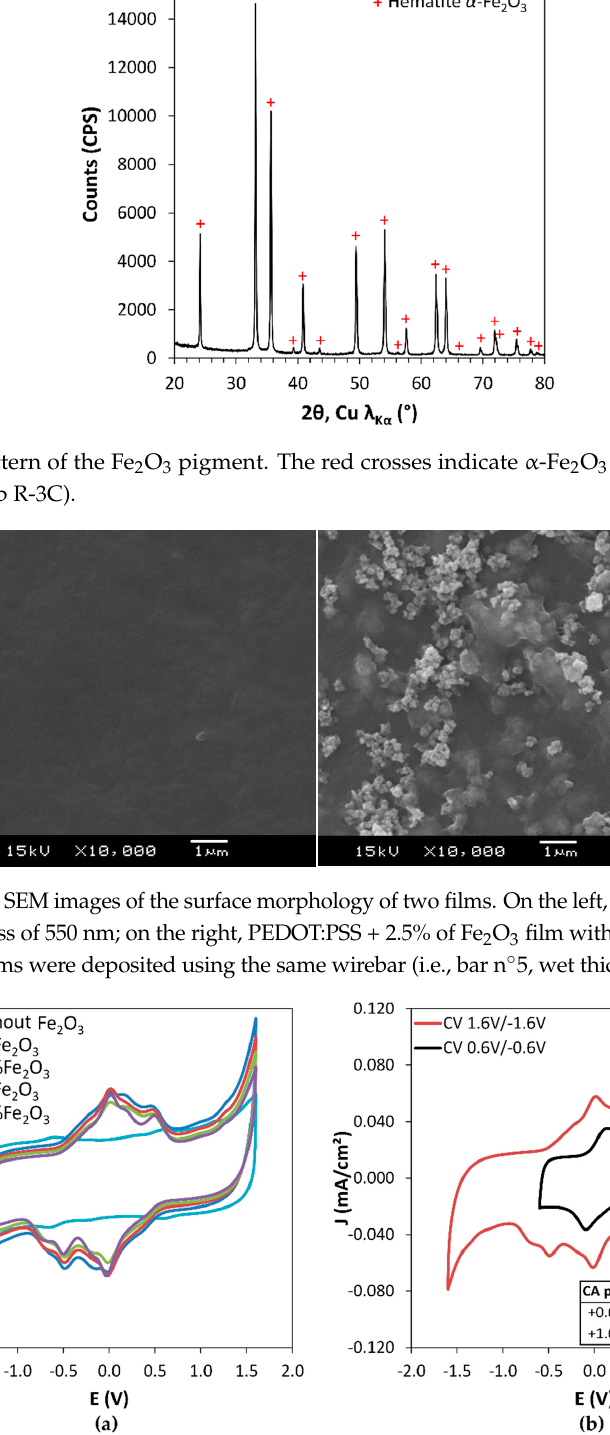
Figure 6. XRD pattern of the Fe 2 O 3 pigment. The red crosses indicate α -Fe 2 O 3 structure diffraction peaks (space group R-3C).